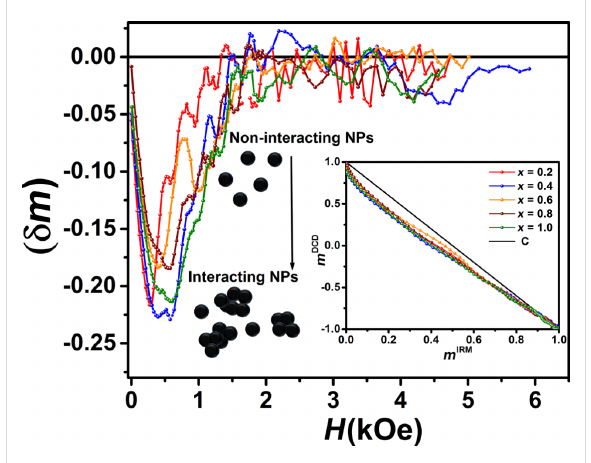
Figure 12: δ m as a function of the magnetic field strength measured at room temperature. The inset shows the Henkel plots.